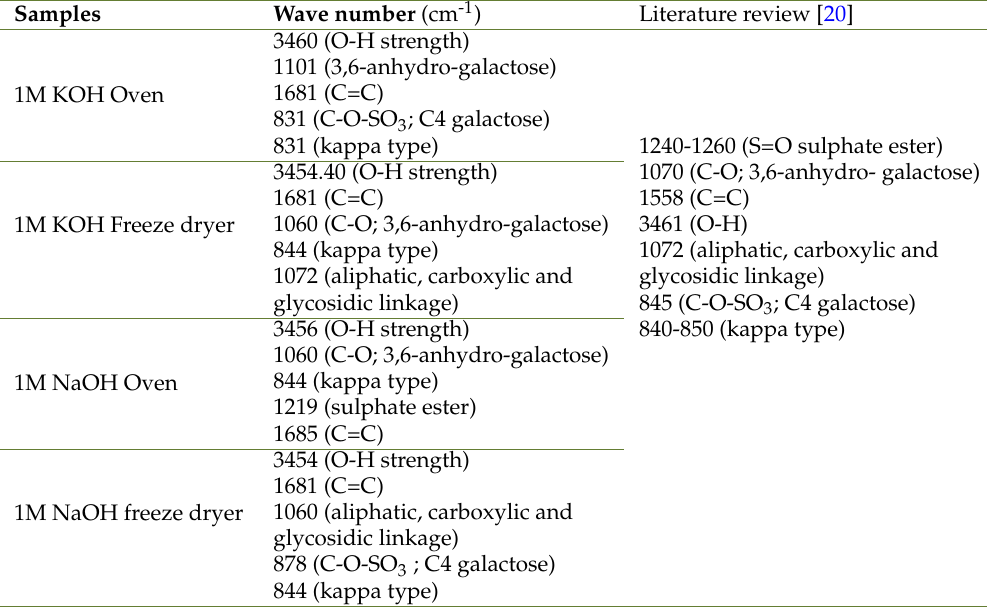
Table 3. Functional group of carrageenan with wave number of each extracted sample